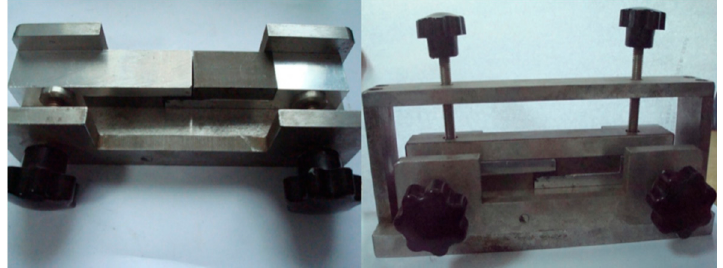
Figure 6. Diagram of lateral fastening jig ( left ) and gantry clamping jig ( right ).